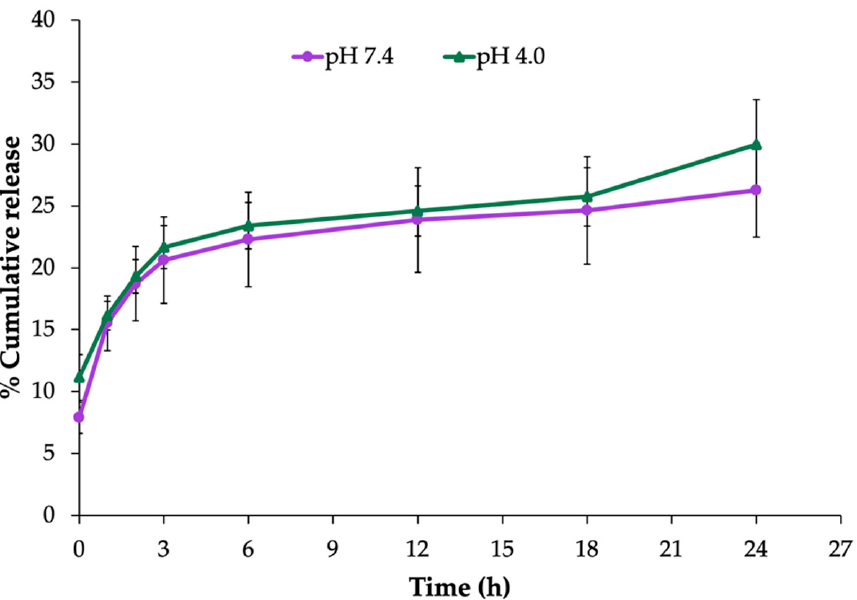
Figure 2. In vitro release profile of the EEP-NPs in PBS, pH 7.4 and pH 4.0, at 37 °C for 24 h. The data are represented as the means ± SEM of three independent trials.